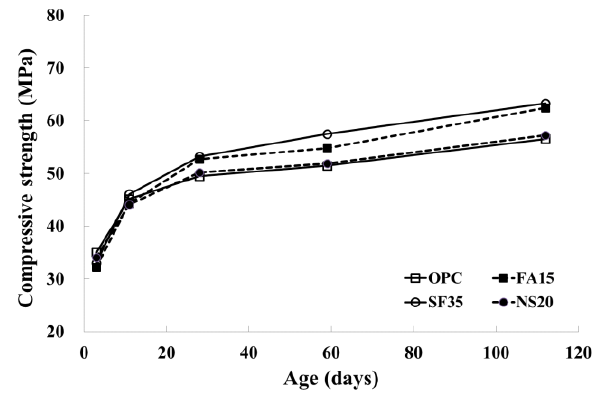
Figure 2. Compressive strength vs. age.